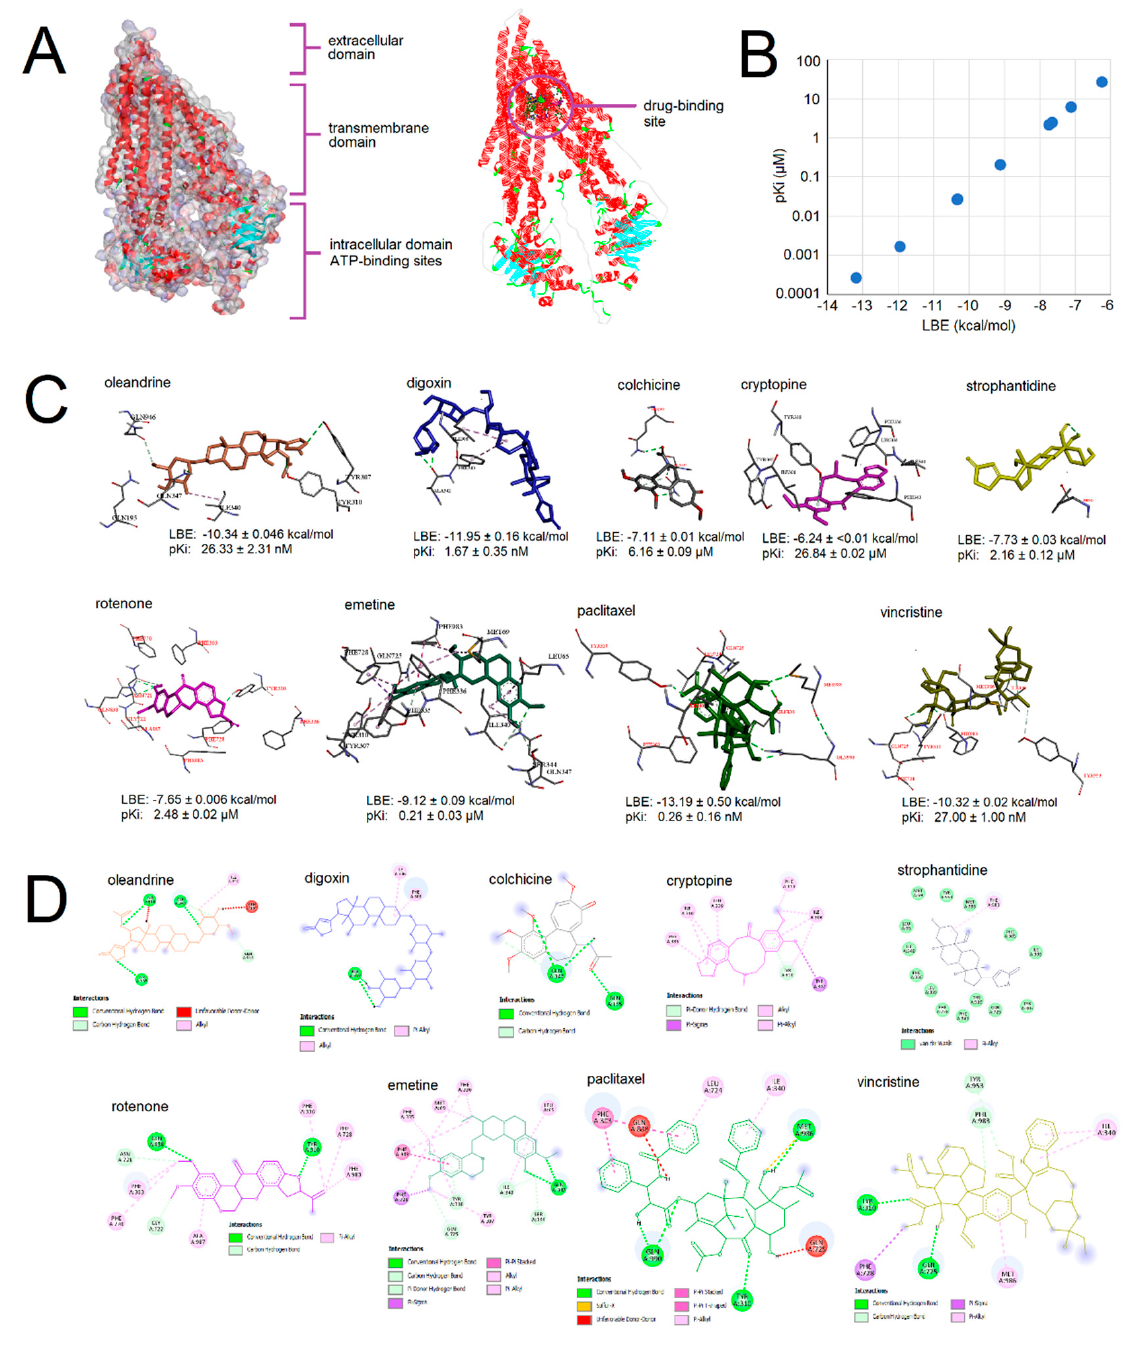
Figure 3. Molecular docking of seven selected phytochemicals to a human homology model of P-glycoprotein in the open conformation. ( A ) Extracellular domain, transmembrane domain, intracellular domain with ATP-binding sites, and drug-binding site of P-glycoprotein. ( B ) Correlation of lowest binding energies (LBE, kcal/mol) and predicted inhibition constants (pKi, µM) of seven selected phytochemicals. ( C ) Binding orientation of the selected phytochemicals at the drug-binding site. ( D ) Interaction of the selected phytochemicals with amino acid residues at the drug binding site. The established anticancer drugs paclitaxel and vincristine were chosen as control drugs, as they are well-known to be transported by P-glycoprotein.